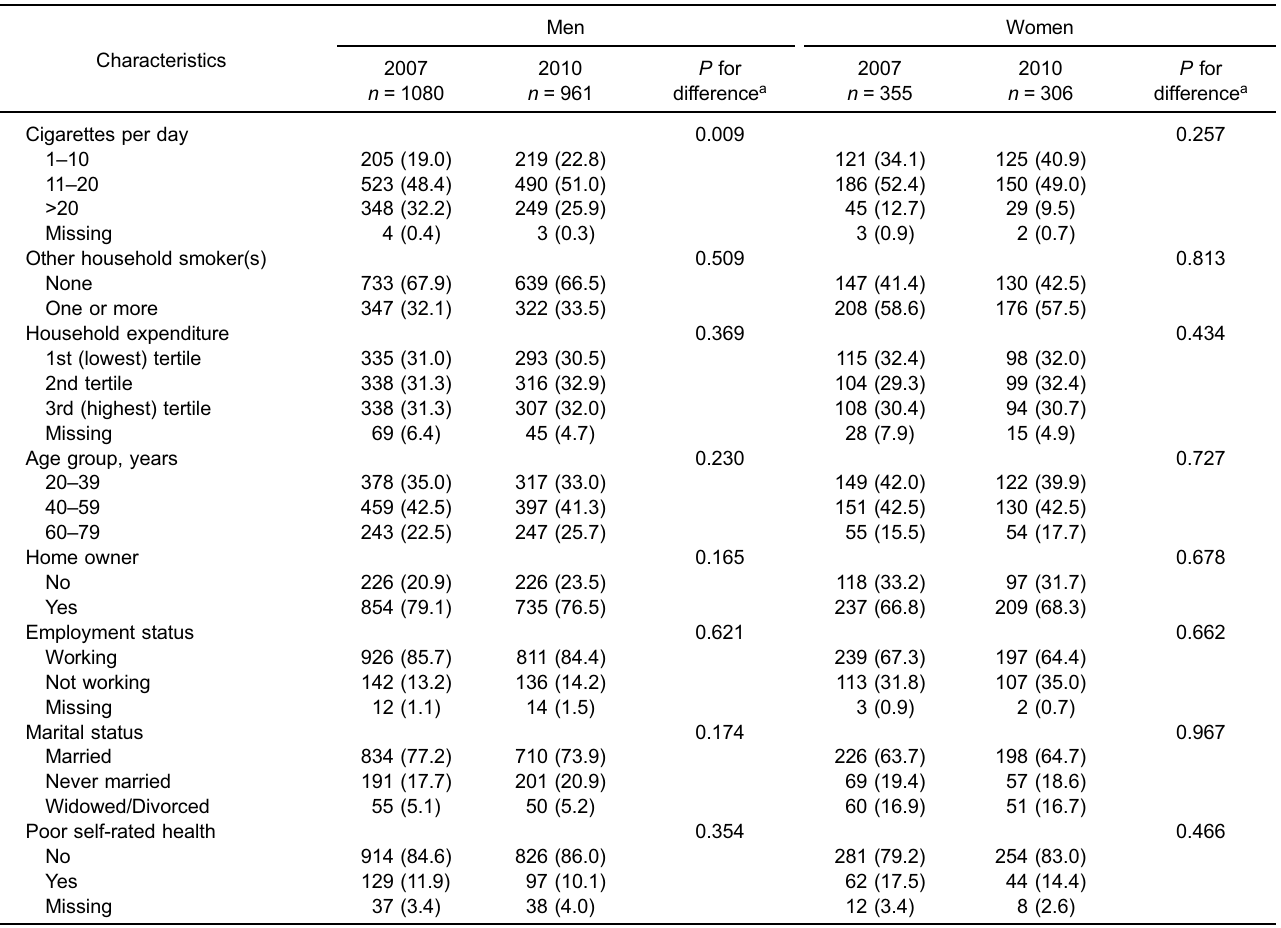
Table 1. Basic characteristics of current smokers in June, comparison between 2007 and 2010 (baseline)